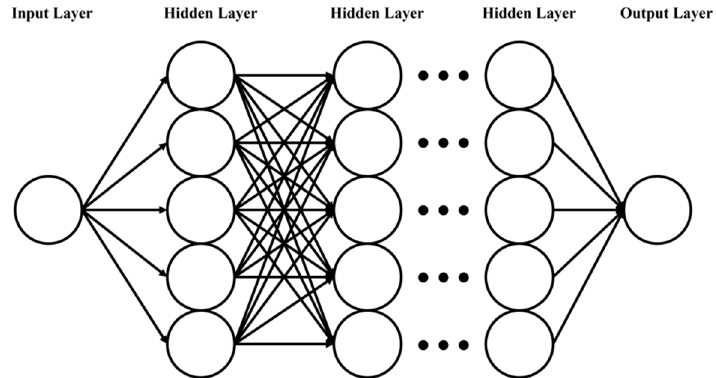
Figure 11. Illustration of a Deep Neural Network.